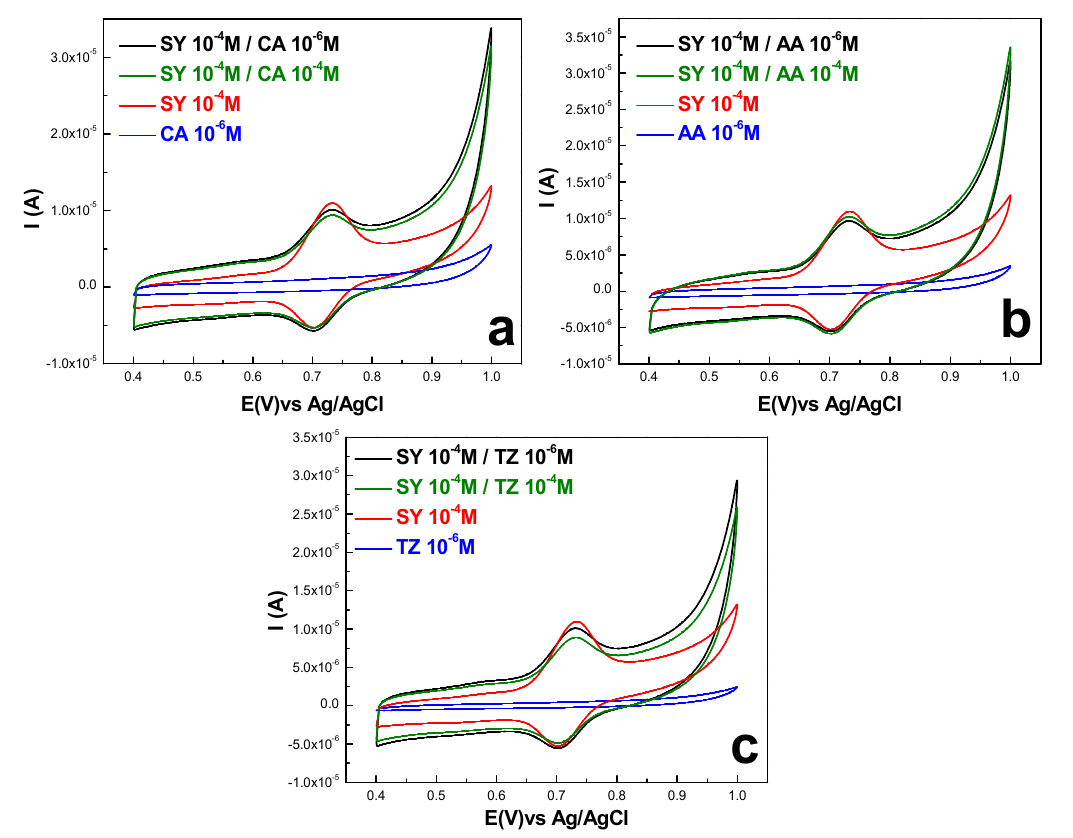
Figure 7. ( a ) CV response of GR-exf/GC-modified electrode toward 100 µM SY in the presence of different organic interferences set at two fixed concentrations of 1 µM and 100 µM: ( a ) citric acid (CA); ( b ) ascorbic acid (AA); ( c ) tartrazine (TZ). Supporting electrolyte pH 6 PBS, scanning rate 10 mV/s. In order to test the validity of the SY detection method, the analysis was performed in real sample solution. Triferment was selected from the pharmaceutical drugs that contain the artificial colorant, Sunset Yellow. Since in this case, SY was present only in the film surrounding the tablet, the following procedure was applied. One tablet was immersed in a beaker containing 5 mL of pH 6 PBS and left in the solution until the film was completely dissolved (the tablet core was removed from the solution after film dissolution). This was considered the stock solution for SY in Triferment. A volume of 200 µL from the stock solution was mixed with 4.8 mL pH 6 PBS and denoted the unknown concentration (C x ) of SY in Triferment. Next, three volumes (e.g., 50, 100 and 150 µL) of SY standard solution (10 −3 M in pH 6 PBS) were added to three beakers, each also containing C x (the final volume in the beakers was 5 mL). The electrochemical signal corresponding to each solution was recorded with a GR-exf/GC-modified electrode (Figure 8a), and then, the peak current (I pa ) was plotted versus SY concentration. From the obtained calibration plot (Figure 8b), the C x concentration was determined to be 2.2 µM. By taking into account that C x was 25 times diluted from the stock solution, the SY concentration in the stock was determined to be 55 µM.